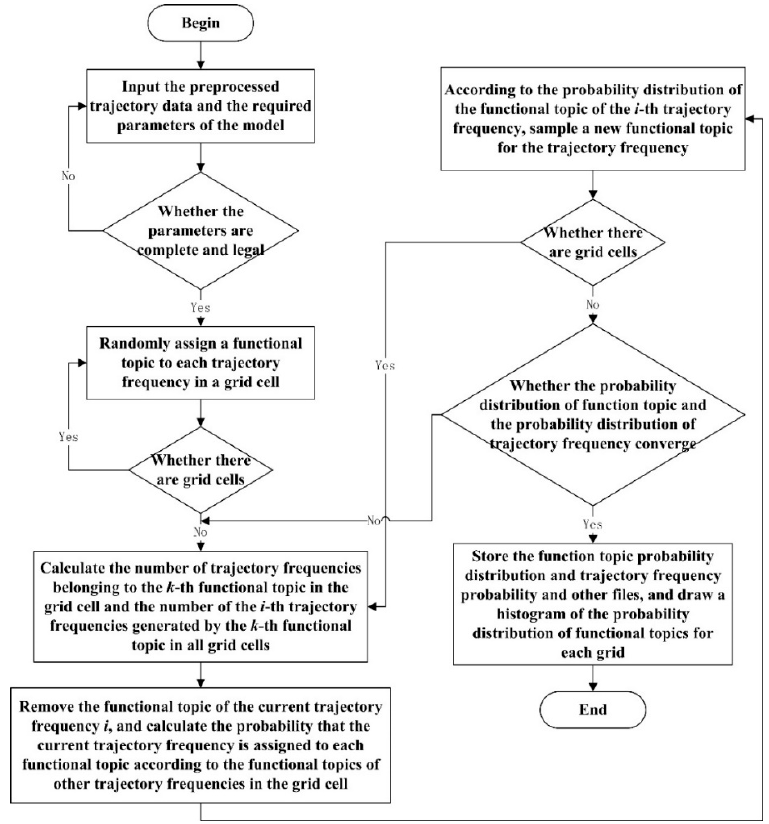
Figure 4. Histogram-latent Dirichlet allocation (H-LDA) model calculation process.